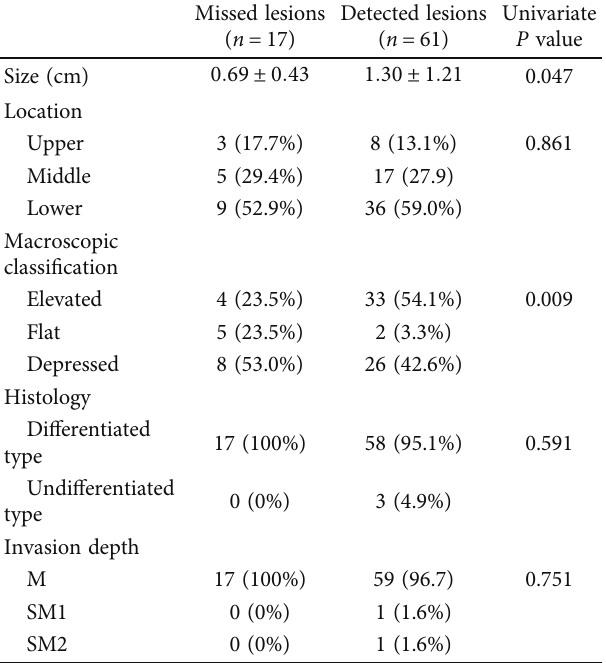
Table 6: The clinicopathologic features between missed lesions and detected